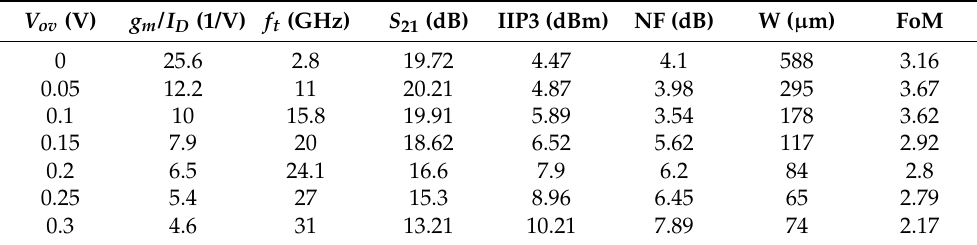
Table 1. The LNA parameters according to V ov .